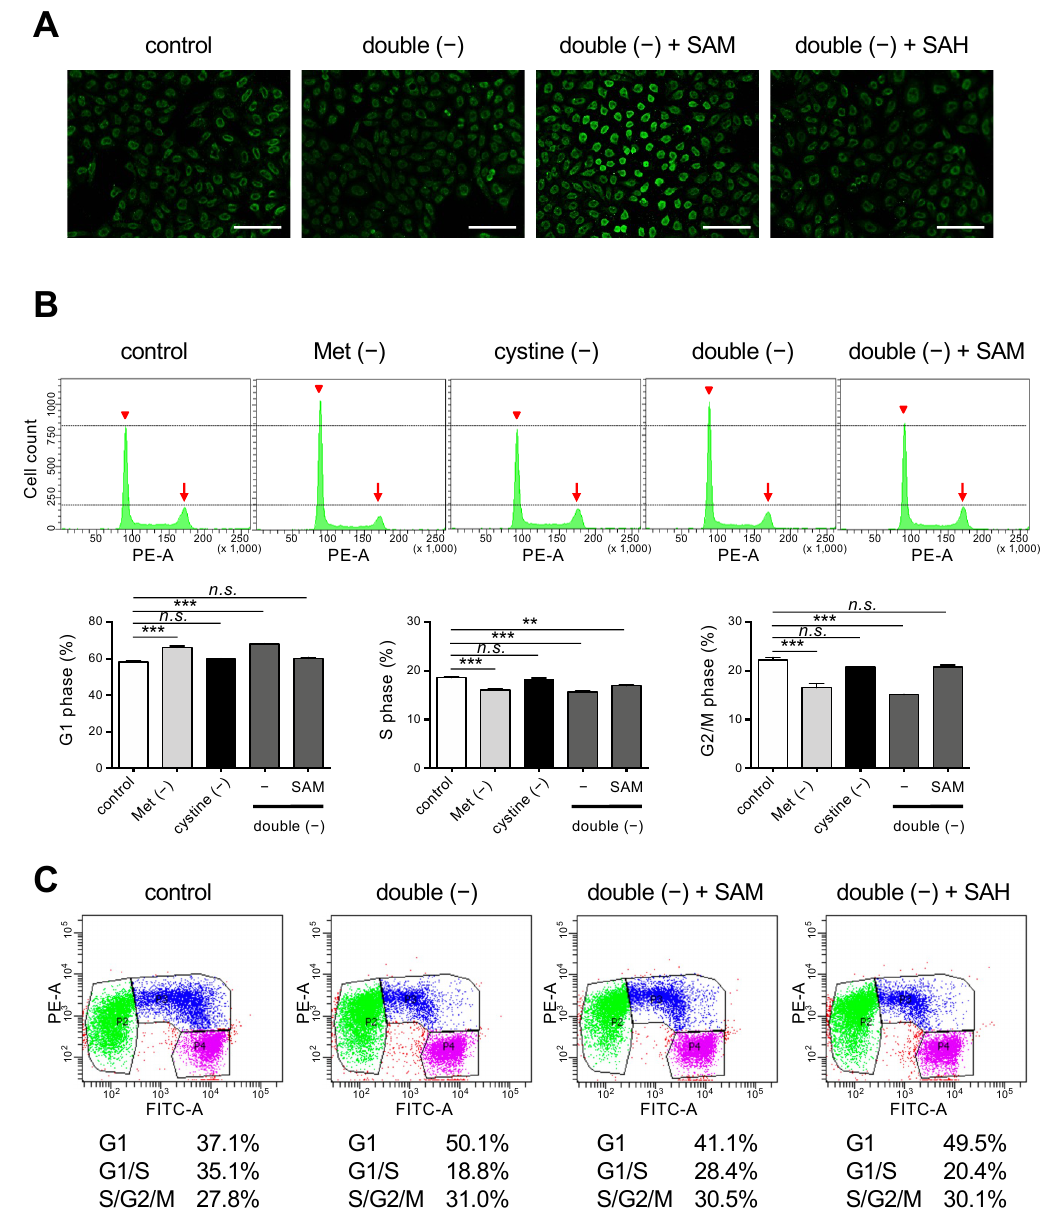
Figure 4. Effects of SAM on cell cycle regulation under Met/cystine double-free conditions. ( A ) Immunostaining with anti-5mC antibody. HeLa cells were incubated in complete (control) or Met/cystine double-free medium supplemented with or without 0.2 mM SAM or 0.2 mM SAH for 12 h, and then stained with an anti-5mC antibody (green). Bars: 100 µ m. ( B ) Cell cycle analyses by PI staining. HeLa cells were incubated in complete (control), Met-free, cystine-free, or Met/cystine double-free medium supplemented with or without 0.2 mM SAM for 18 h. After staining with PI, the HeLa cells were analyzed by flow cytometry. Arrowheads and arrows indicate the positions of 2N and 4N, respectively. Bottom panels indicate the distribution of the cell-cycle phases. Data represent the mean ± SEM ( n = 3). **: p < 0.01, ***: p < 0.001 (Dunnett’s test). n.s.: not significant. ( C ) Cell cycle analysis with the Fucci indicators. HeLa/Fucci cells were incubated in complete (control) or Met/cystine double-free medium supplemented with or without 0.2 mM SAM or 0.2 mM SAH for 18 h, and then subjected to flow cytometry. Cell populations in G1-, G1-/S-, and S-/G2-/M-phase are represented by green, blue, and purple, respectively. Values indicate the proportion of cells in each phase of the cell cycle (the mean of triplicate